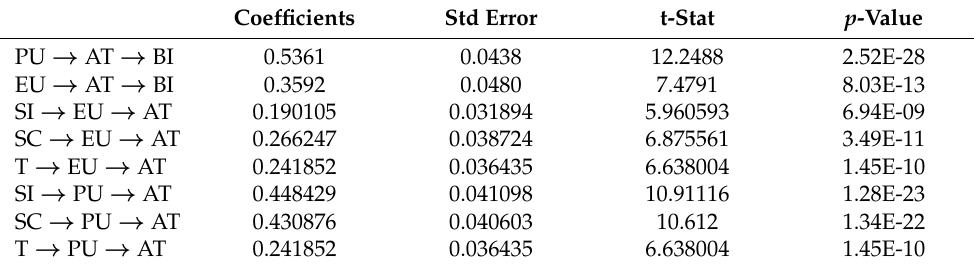
Table 15. Results of Sobel Test.